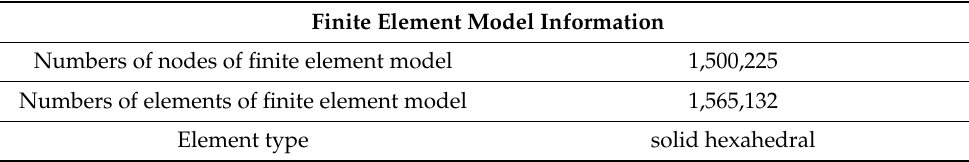
Table 1. Information of finite element